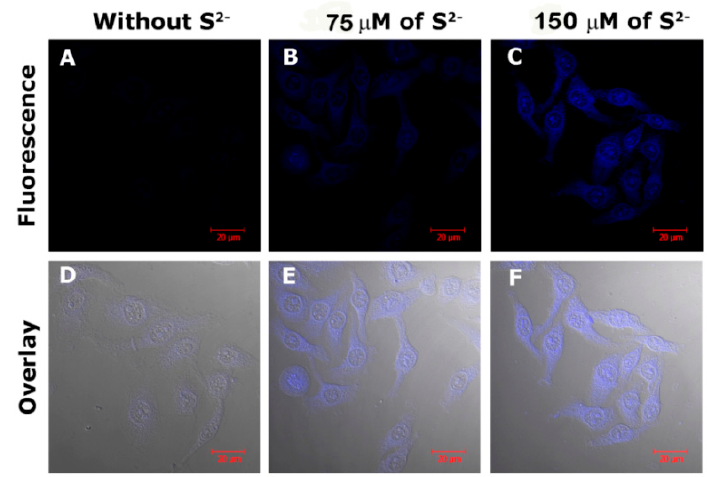
Figure 10. Confocal images of HeLa cells incubated with the FCD sensor (FCD, 50 µ g mL − 1 ) and 100 µ M of Cu 2+ ( A , D ), and then treated with 75 µ M ( B , E ) and 150 µ M of S 2 − ( C , F ). The overlay images confirm the signals are from in-cell FCDs, not interference.